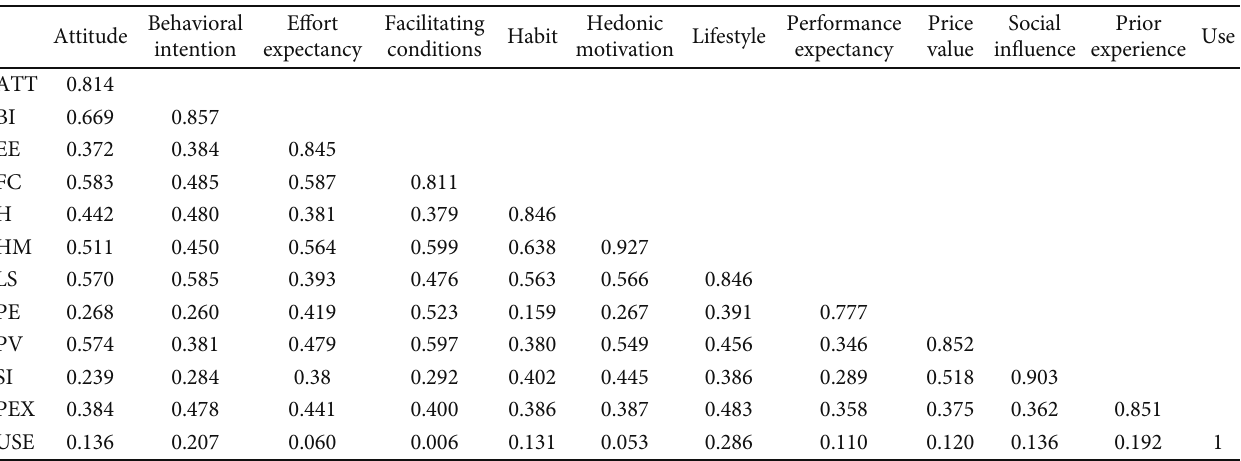
Table 7: Correlation of latent constructs.